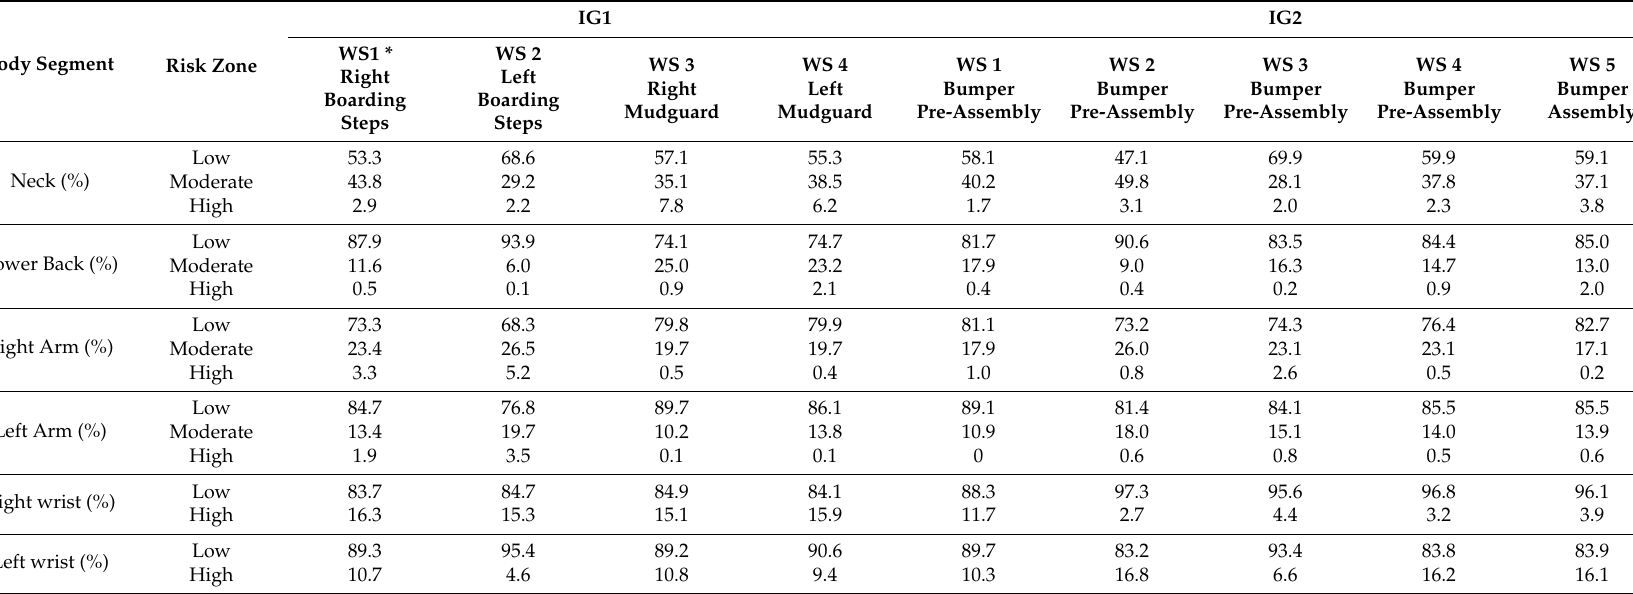
Table 3. The proportion of time in awkward posture (flexion / extension) for workstations (WS) over one cycle time (Eight min) for Improvement Groups 1 (IG1) and 2